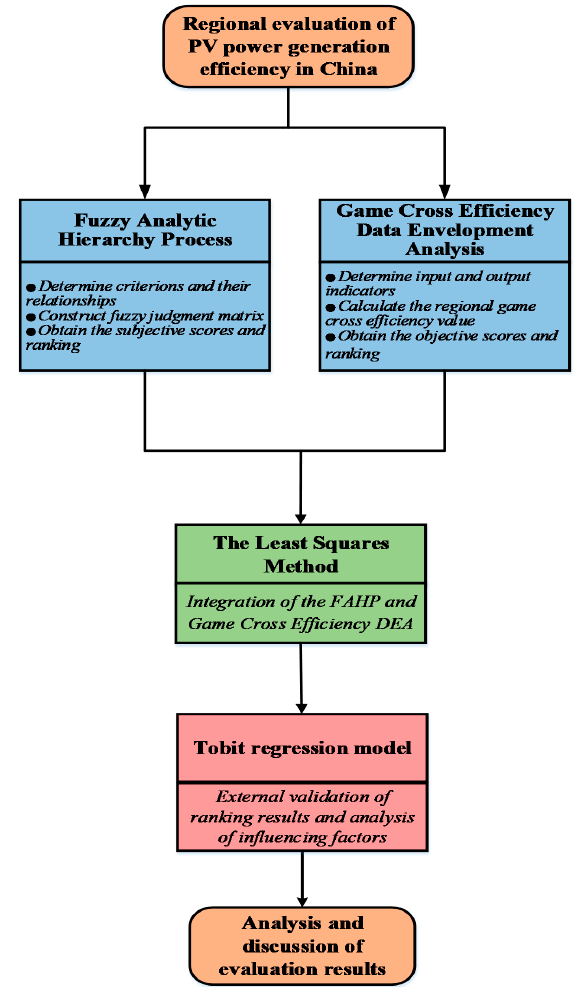
Figure 2. Article framework.